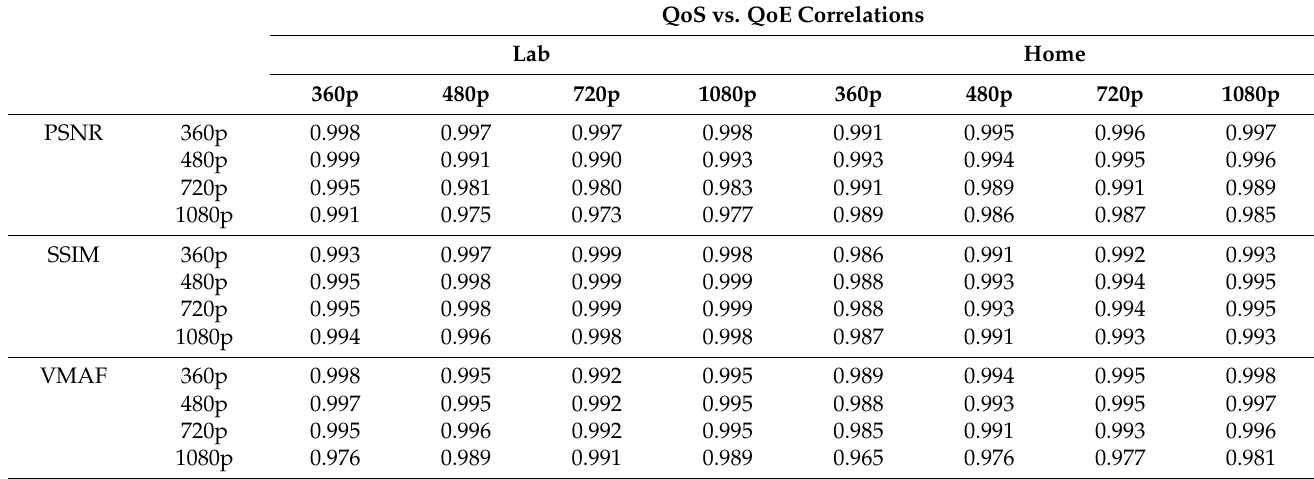
Table 11. Correlations between QoS and QoE values (in the lab and home) for H.265 encoded video. QoS vs. QoE Correlations